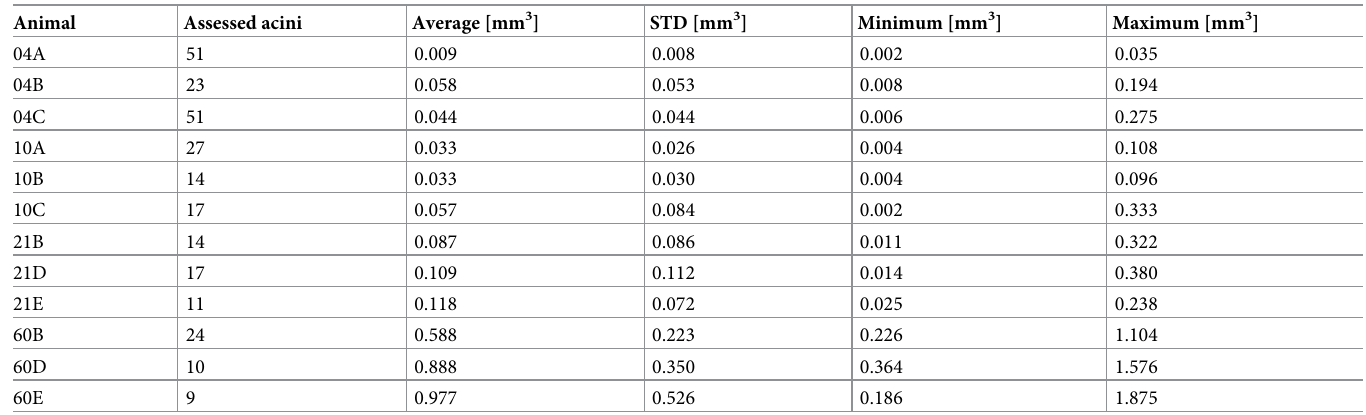
Table 2. Detailed volume data (in mm 3 ) for each